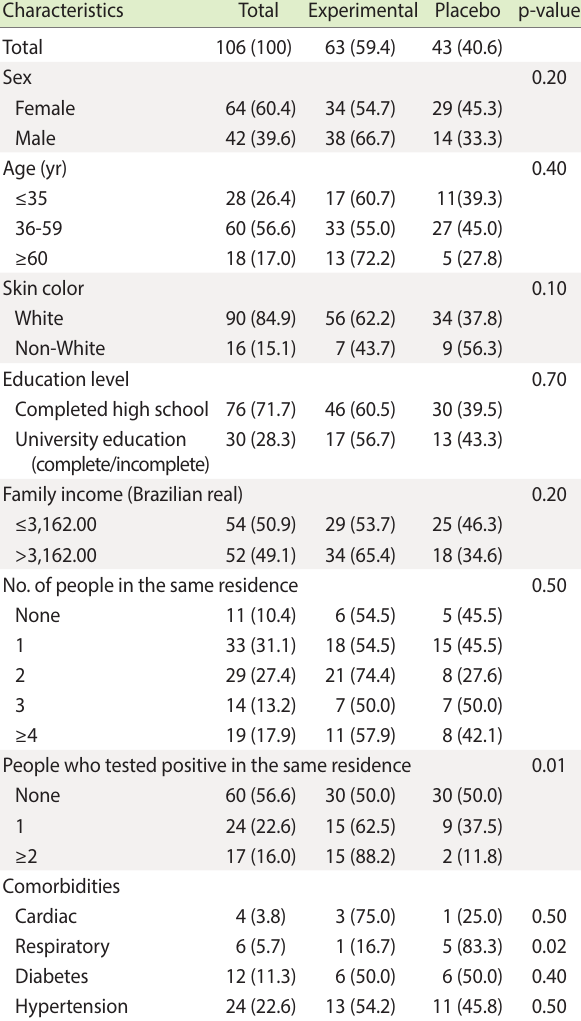
Table 1. Demographic characteristics of patients at baseline Characteristics